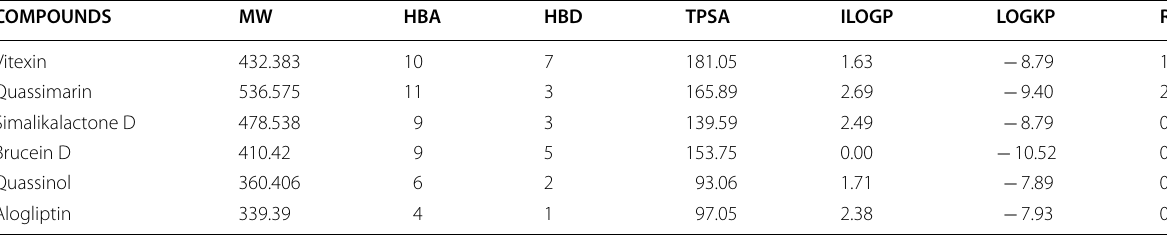
Table 3 In-silico drug likeness prediction of the compounds